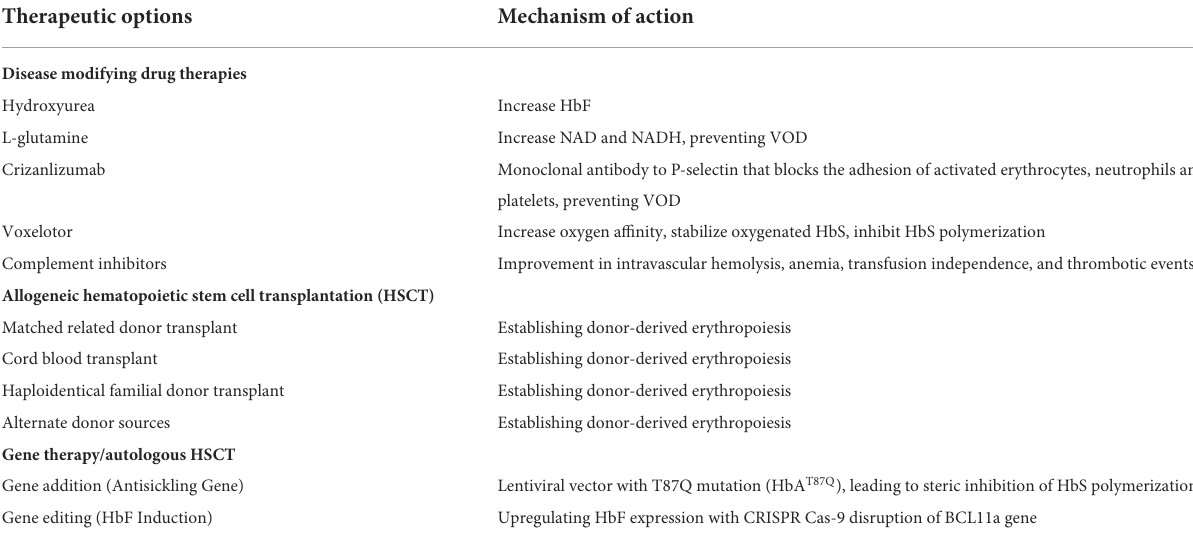
TABLE 1 Sickle cell disease therapeutic